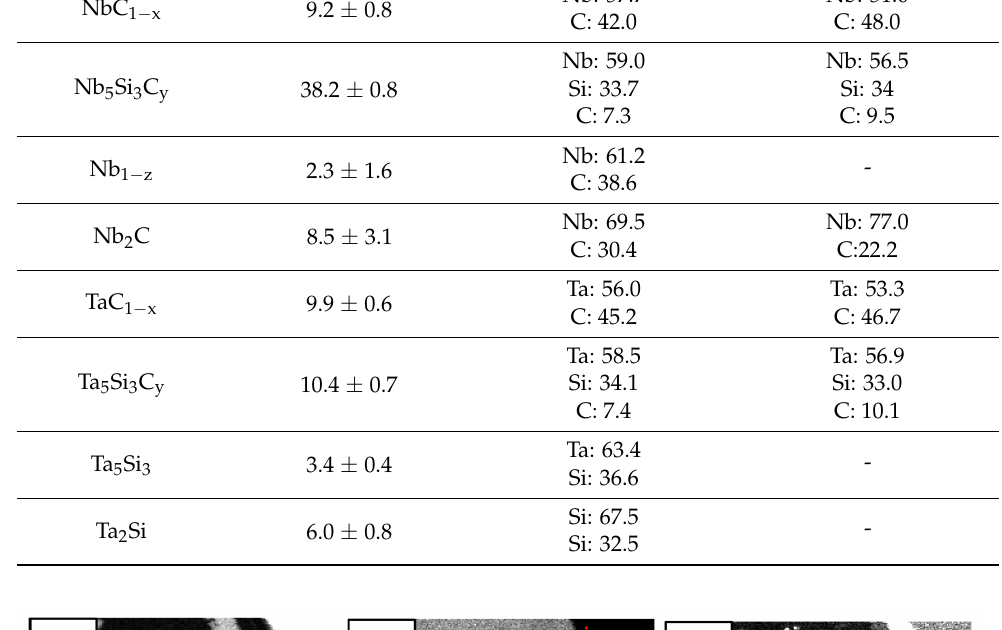
Table 4. Thickness and composition of the different reaction layers analyzed by EPMA and ion beam analyses (NRA for C and Si, PIXE for Ta and Nb) in the Nb/SiC and Ta/SiC systems after 1000 h at 1200 ◦ C. Average EPMA Measurements Ion Beam Analyses Phase Thickness ( µ m) (at.%) (at.%) NbC 1 − x 9.2 ± 0.8